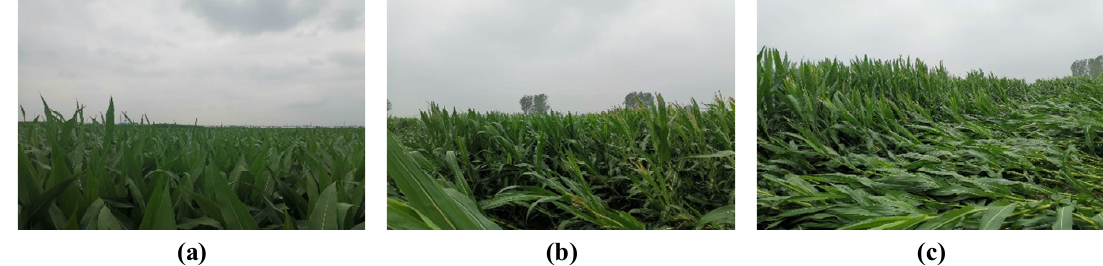
Figure 2. Different degrees of lodging: ( a ) non-lodging (NL), ( b ) light lodging (LL), ( c ) severe lodging (SL). The photos were taken on the experimental plot on August 4.